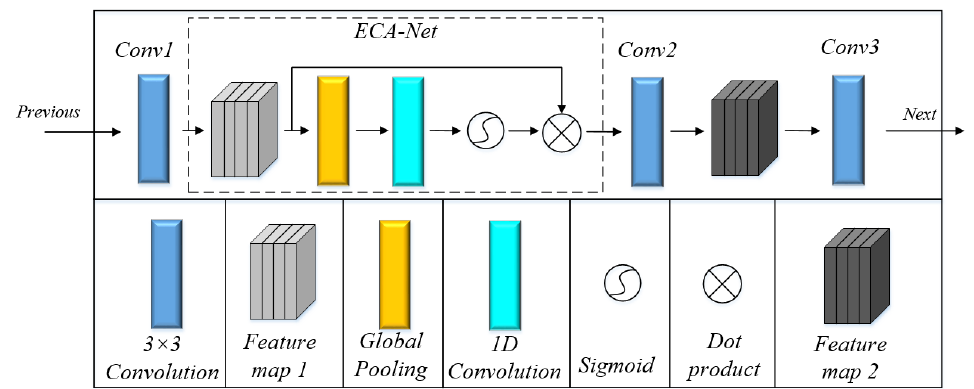
Figure 6. ECA-Net embedding